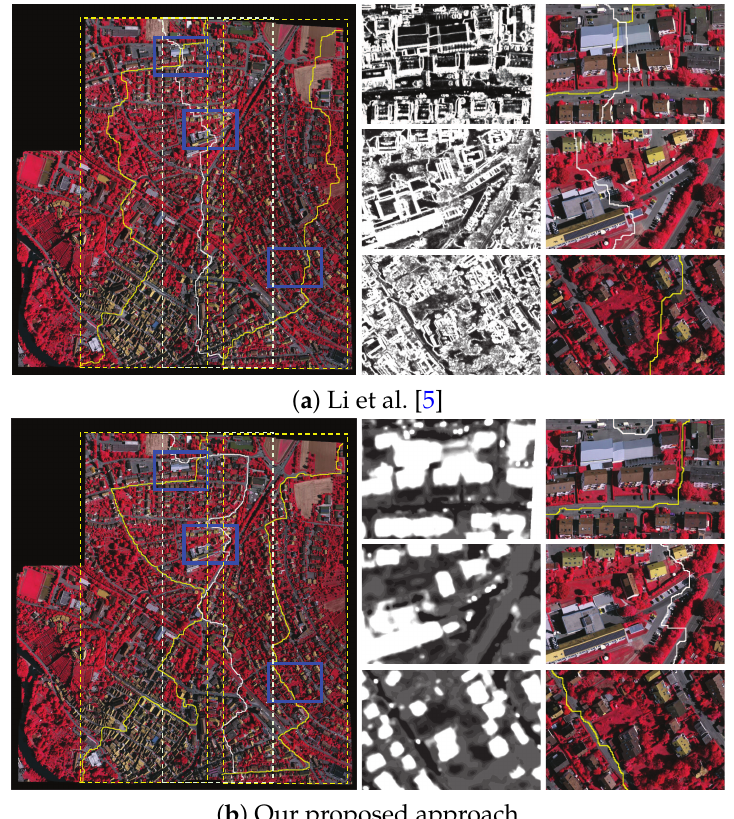
Figure 9. Visual comparison of the seamline detection results generated by Li et al. [5] ( a ) and our proposed approach ( b ). In ( a ) or ( b ), the left pictures are the stitched images drawn with the detected seamlines, the right pictures are three corresponding local enlarged regions of the stitched images, and the middle pictures are the corresponding normalized energy cost maps of local regions, where the brighter regions indicate higher energy costs. The dash boxes represent the overlapped regions between input